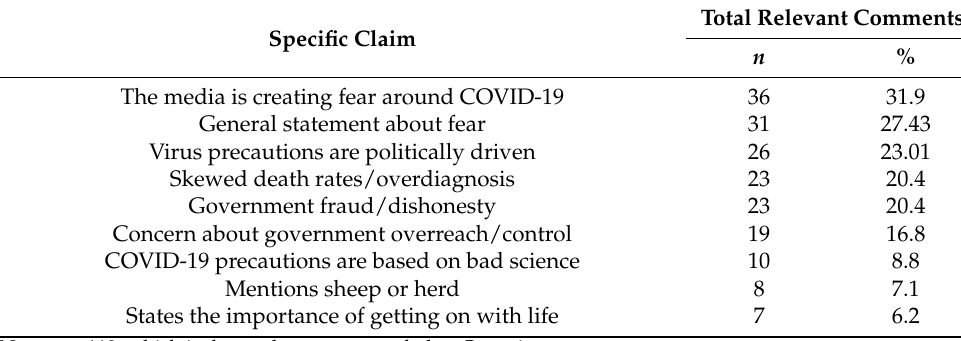
Table 4. Specific claims found in the conspiracy